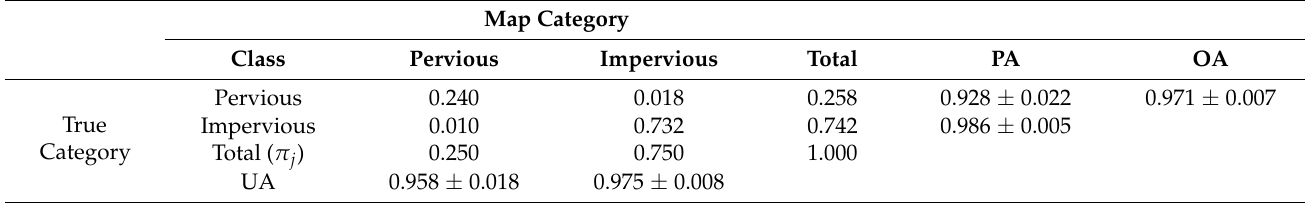
Table 4. Confusion matrix of the impervious and pervious surface extraction results. UA: users accuracy; PA: producers accuracy; OA: overall accuracy; π _j is the class proportion according to the classified map.